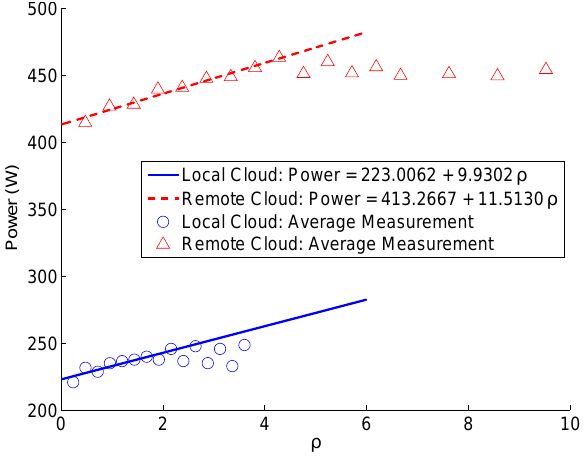
Figure 3. Power consumption of both the local and remote